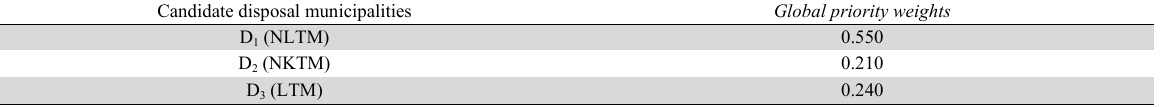
Candidate disposal municipalities